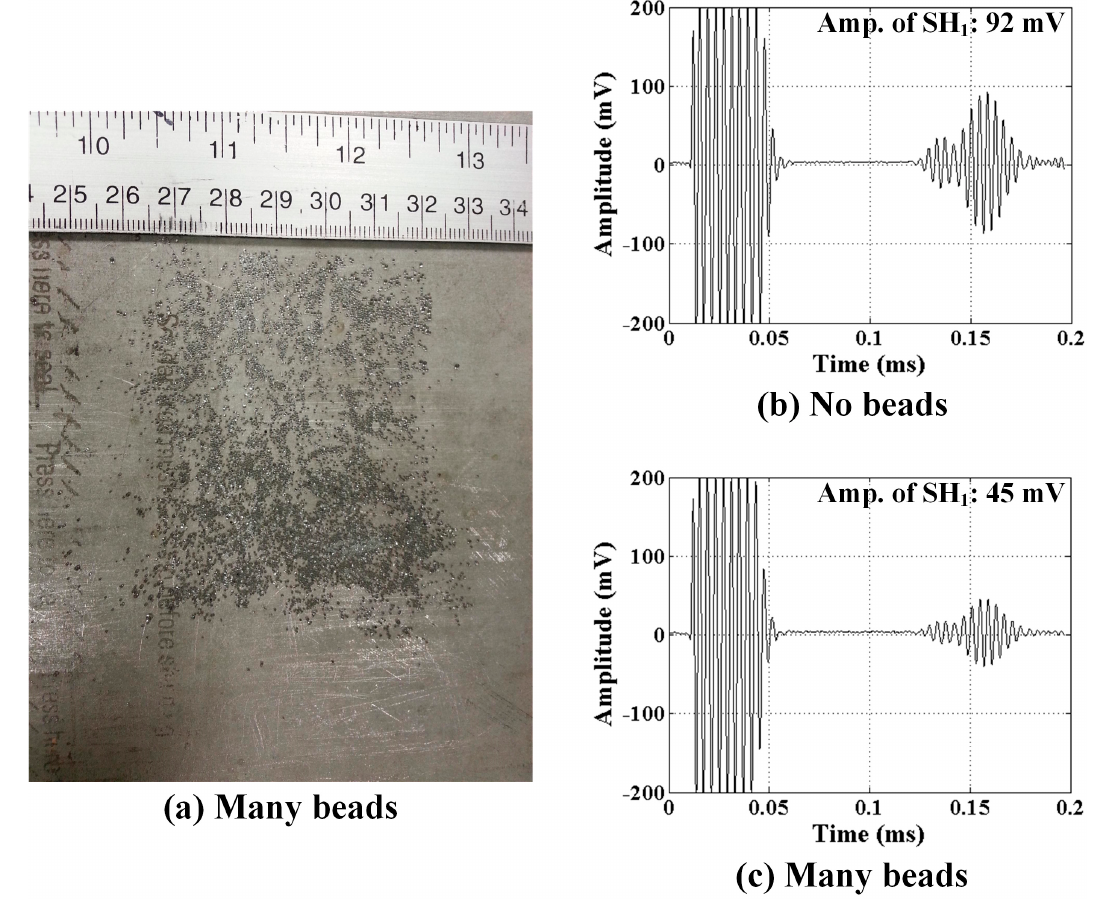
Figure 11. ( a ) Distribution of many glass beads between the EMAT receiver and the substrate; and SH wave signals received for: ( b ) no beads; and ( c ) many beads.